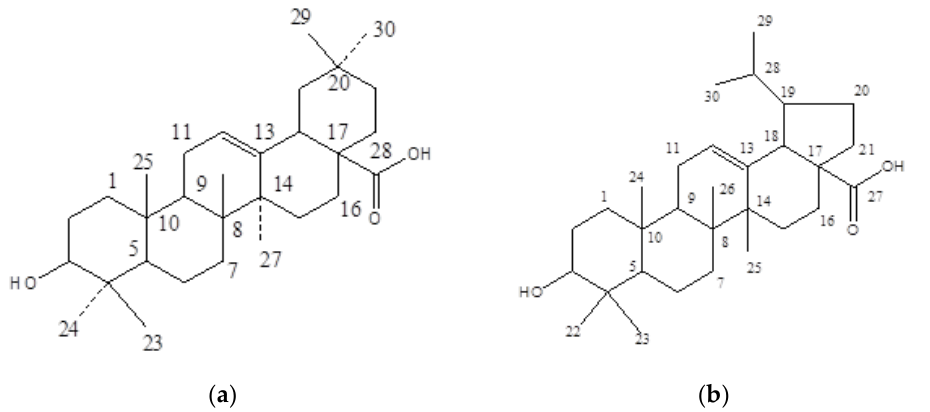
Figure 1. The chemical structures of ( a ) SA-1; and ( b ) SA-4. The SA-1 exhibited ATR-FTIR (cm −1 ) bands at 2917, 2849, 1730, 726; 1 H NMR and 13 C NMR signals (data given in Table 1); ESI-MS signals at m / z : 457 [M+H] + and 456 [M] + ; and HMBC interaction (Figure 2a). Table 1. 1 HNMR and 13 CNMR data for compound SA-1.